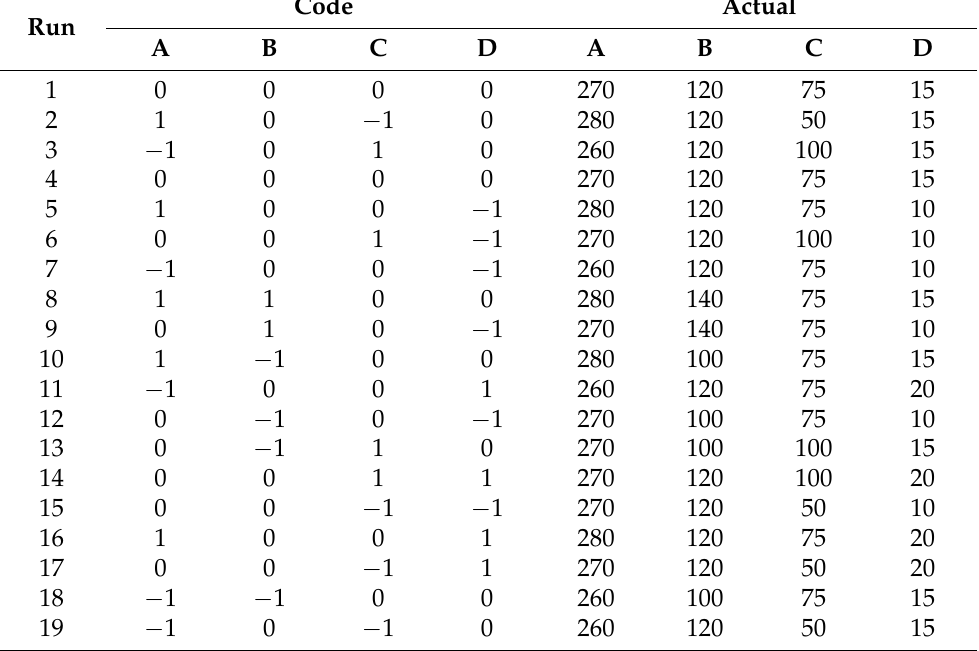
Table 4. Design of